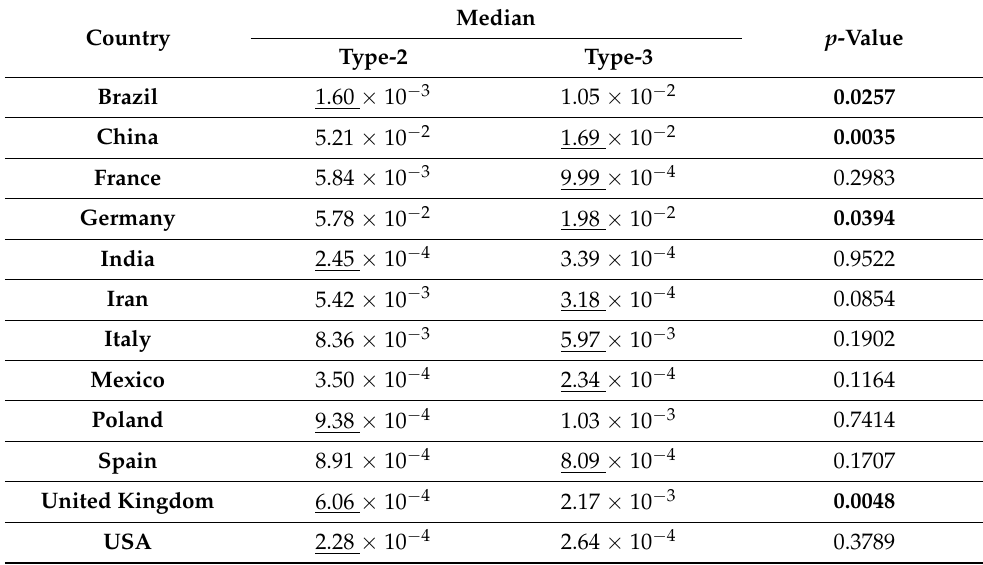
Table 17. Mann–Whitney results (first data period, future prediction).